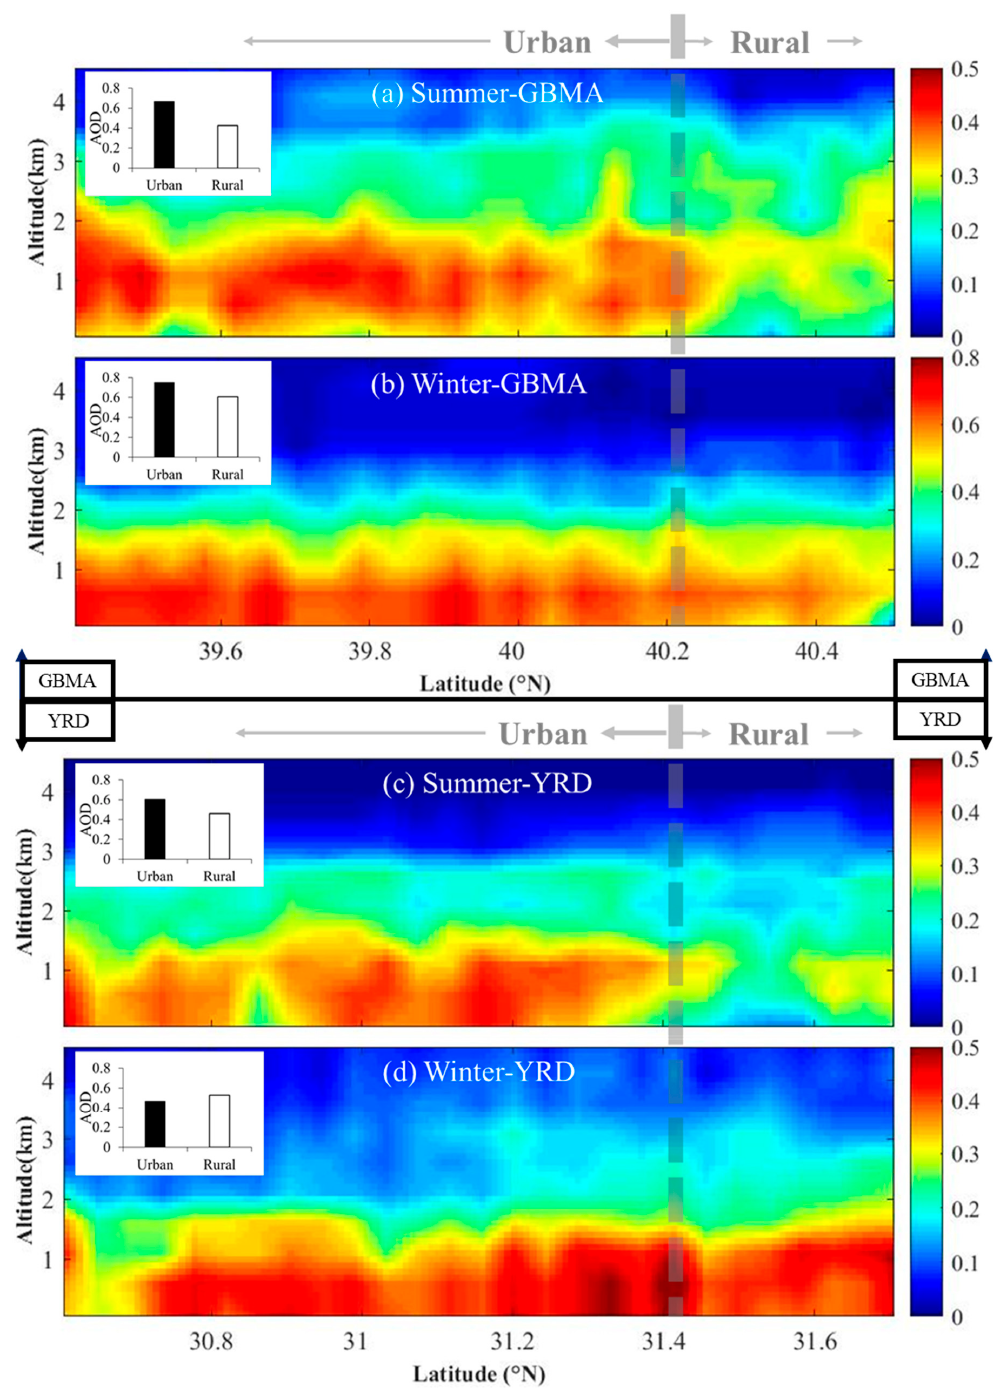
Figure 6. The Cloud–Aerosol Lidar and Infrared Pathfinder Satellite Observation (CALIPSO)-retrieved occurrence frequency of aerosols at different altitudes from urban to rural areas for the data period of 2006 to 2015 for ( a ) the Greater Beijing Metropolitan Area (GBMA) in summer, ( b ) the GBMA in winter, ( c ) the Yangtze River Delta (YRD) in summer, and ( d ) the YRD in winter. The color bars represent the occurrence frequencies of aerosols. The histograms located in the upper-left corner of each panel show the overall mean AODs in rural and urban areas.